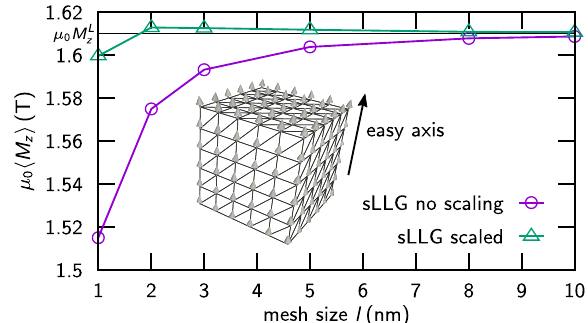
Fig. 5 Magnetization equilibrium. Magnetization in easy-axis direction averaged over 2 ns calculated for different mesh sizes l , with and without scaling of the input parameters M L inset shows an example of a mesh for the test cube with magnetic moments in quasi-equilibrium